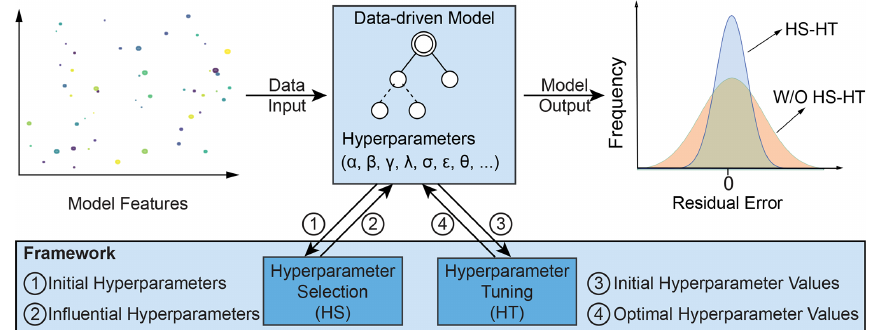
Figure 1. The methodological framework for improving the performance of data-driven models with two modules: hyperparameter selection (HS) and hyperparameter tuning